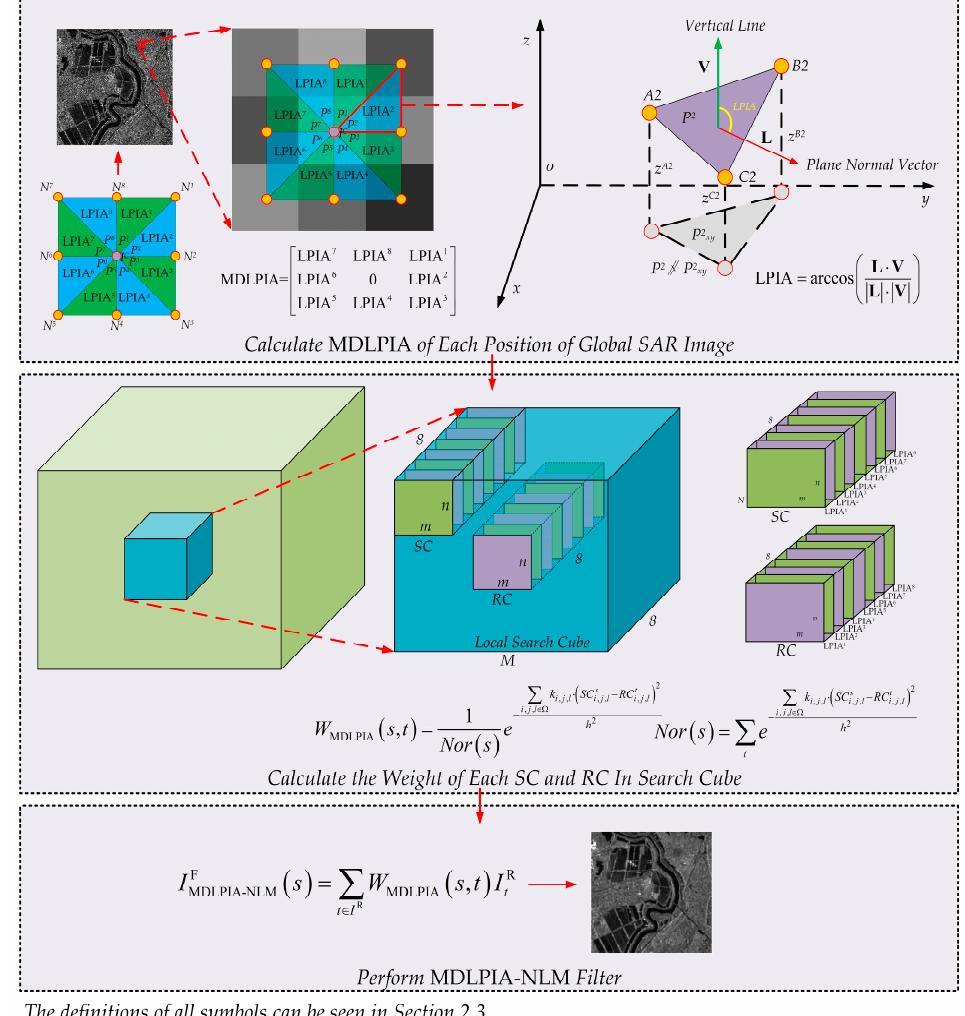
Figure 4. The specific flow chart of proposed filter.